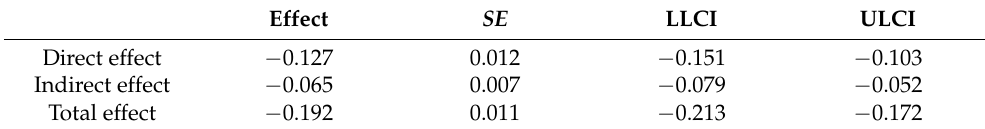
Table 4. The result of direct effect, indirect effect, and total effect.